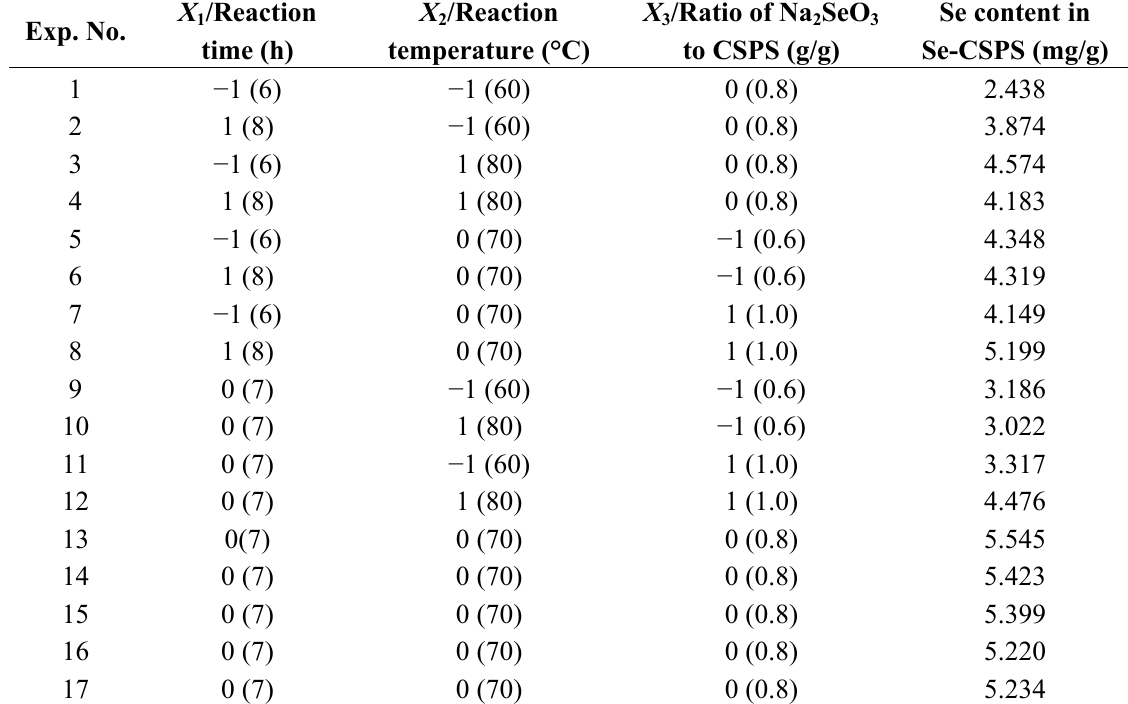
Table 1. Box-Behnken design matrix of three variables and the experimental observed responses. Exp.